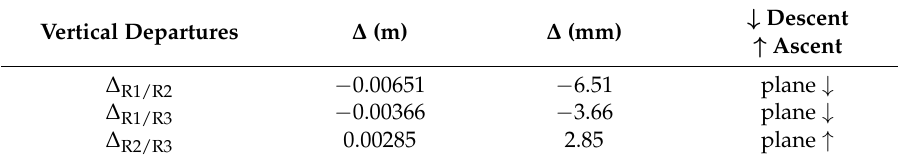
Table 4. Vertical departures between individual time